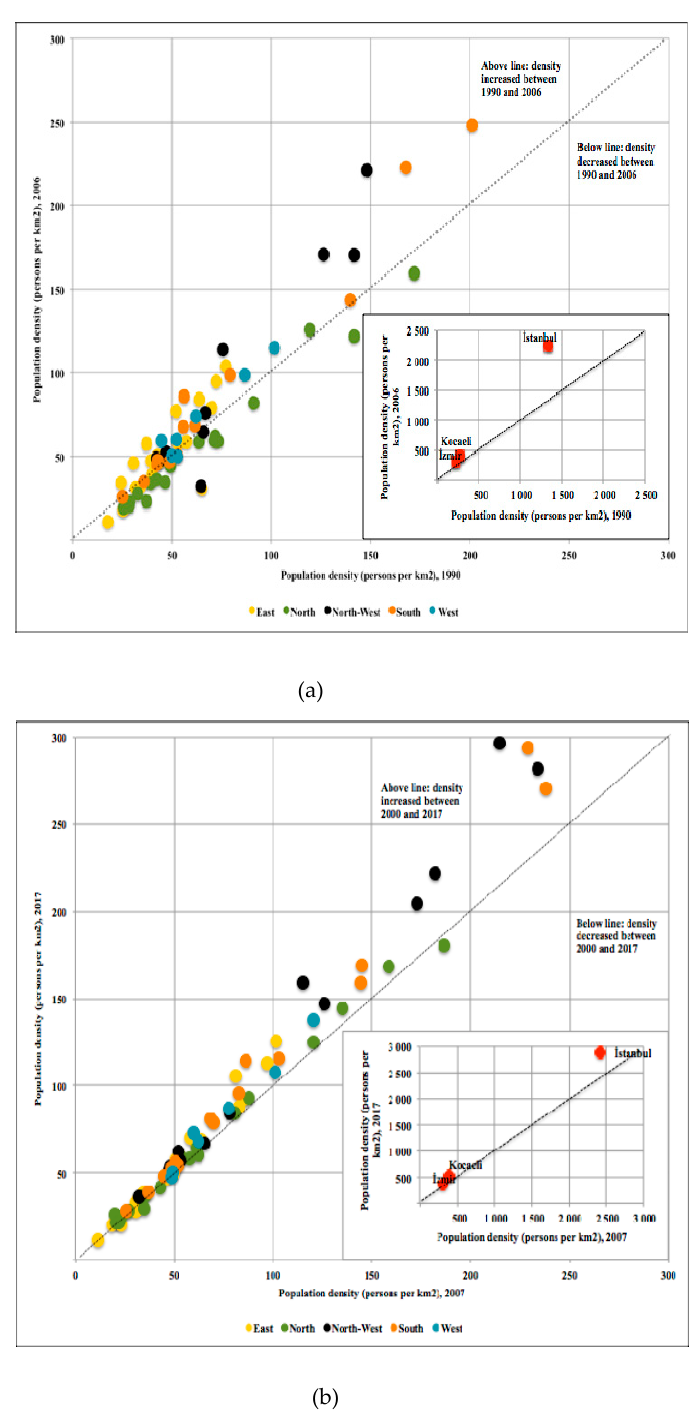
Figure 7. Average population density for each NUTS3 region in Turkey (a) 1990–2006, (b) 2007–2017. Note: The small figures on the right lower corner represent development of population densities in the three highest density ranked cities i.e., Istanbul, Kocaeli and Izmir. Source: Data obtained from Turkstat 55 , figure adopted from Angel et al. 82 .